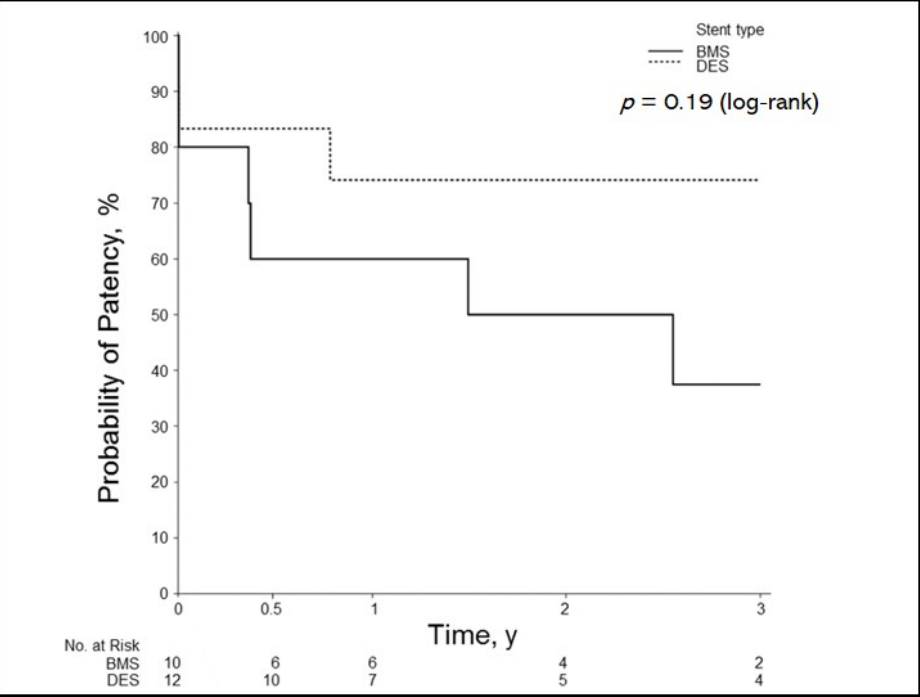
Figure 2. Patency outcomes by stent type for small-caliber arteries. Results of Kaplan–Meier analysis show primary patency of DES vs. BMS in hepatic artery stenosis for stent diameters of 3.5–4.5 mm. BMS indicates bare-metal stent; DES, drug-eluting stent. y,